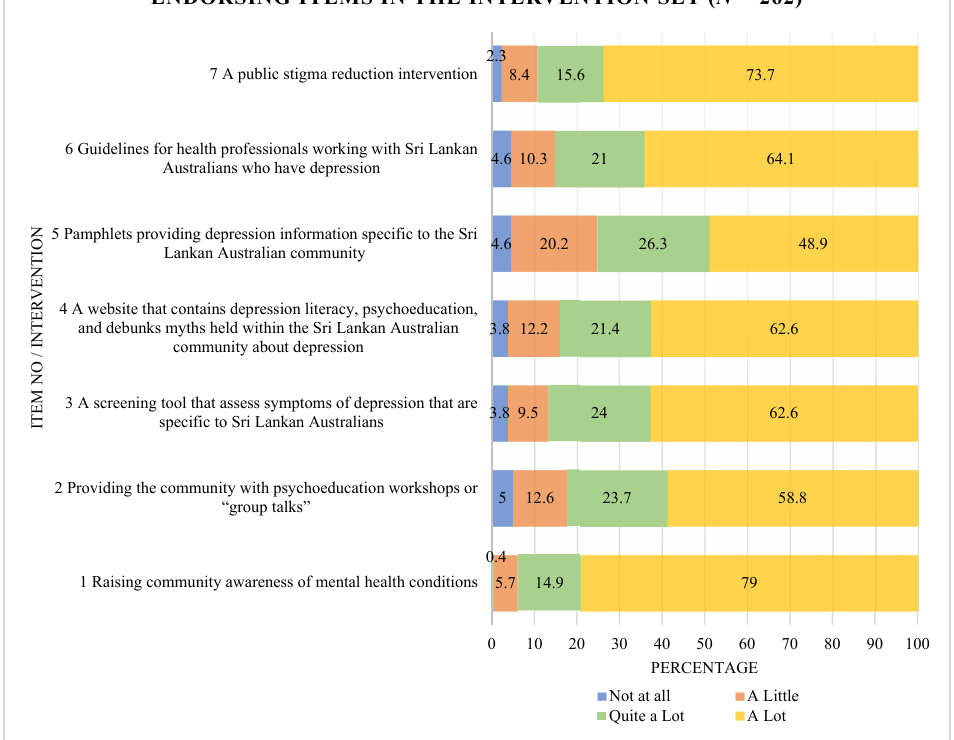
Figure 2. Proportion of the sample endorsing Intervention Set items ( N = 262).